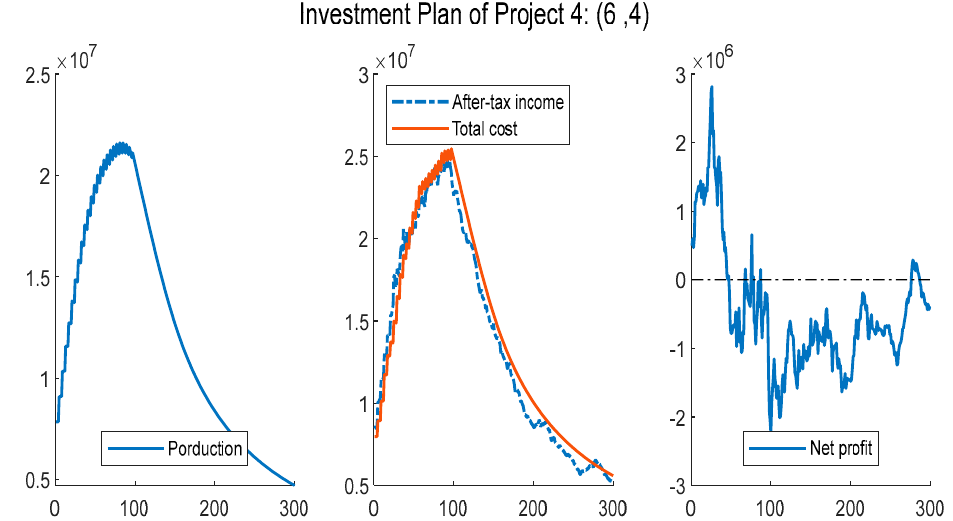
Figure A2. Production, income, cost and, net profit of project 4.